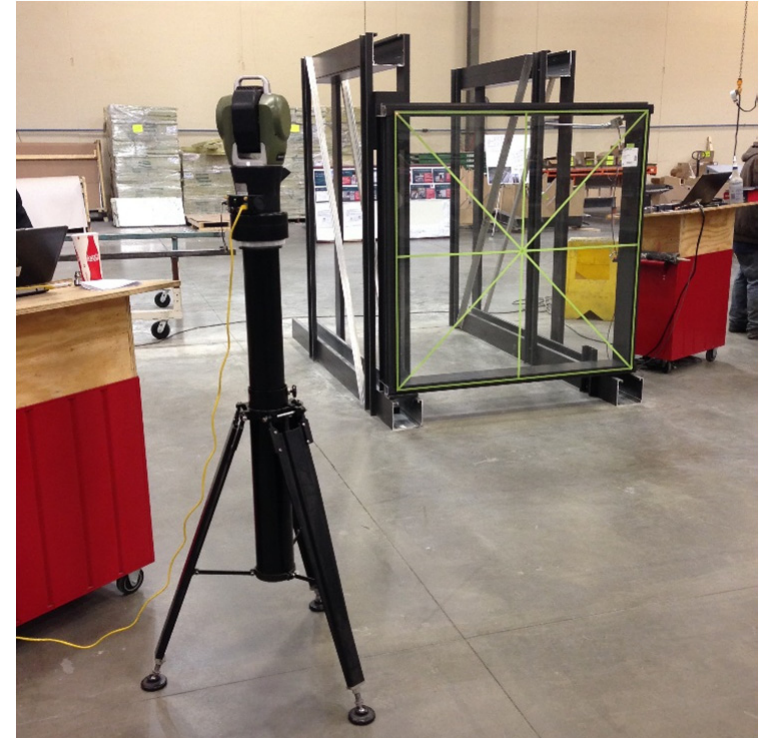
Fig. 8 Laser Tracker Station and Adjustable Cold Formed Testing